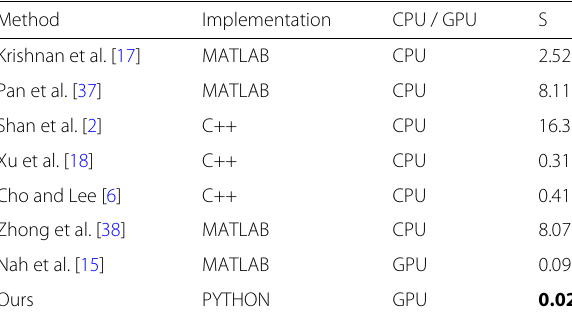
Table 4 Comparison of execution time. We report the average execution time on 10 images with the size of 128 ×